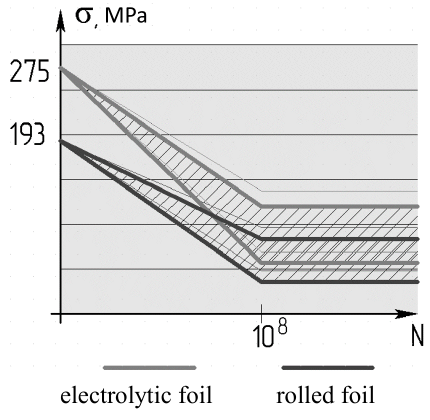
Fig. 2. Stress-number curve.